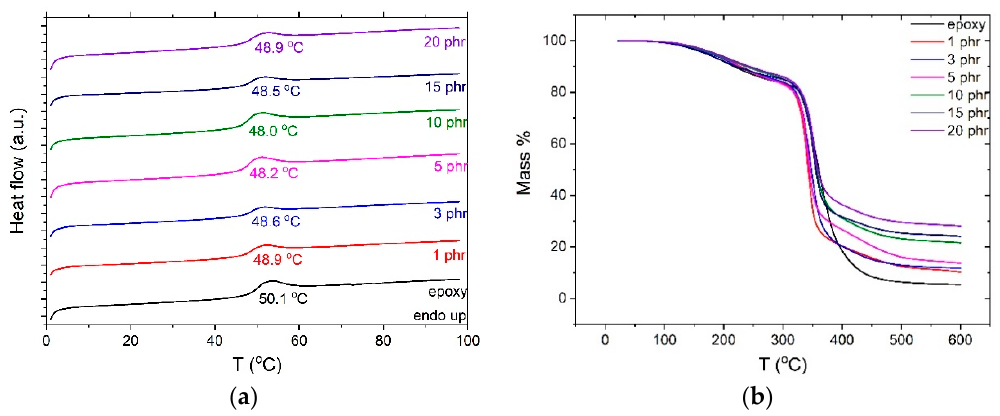
Figure 3. ( a ) DSC and ( b ) TGA thermographs for all examined systems.